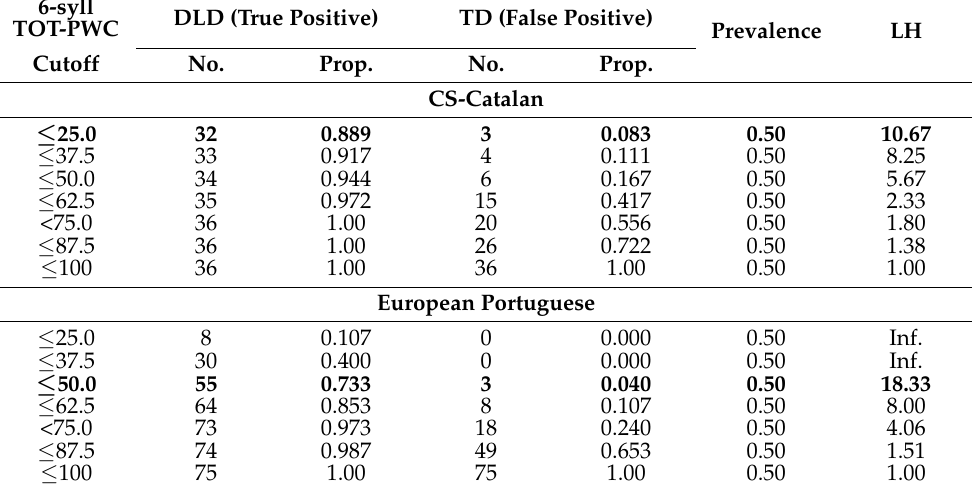
Table 11. The number and proportion of children with a positive test result (ruling in disorder), prevalence and likelihood ratio (LH) for each of the cutoff value based on total word percentage correct (TOT-PWC) for 6-syllable length nonwords for the Catalan–Spanish (CS) and European Portuguese (EP) children with developmental language disorder (DLD) and typically developing (TD) controls. 6-syll DLD (True Positive) TD (False Positive) TOT-PWC Prevalence LH Cutoff No. Prop. No. Prop. CS-Catalan ≤ 25.0